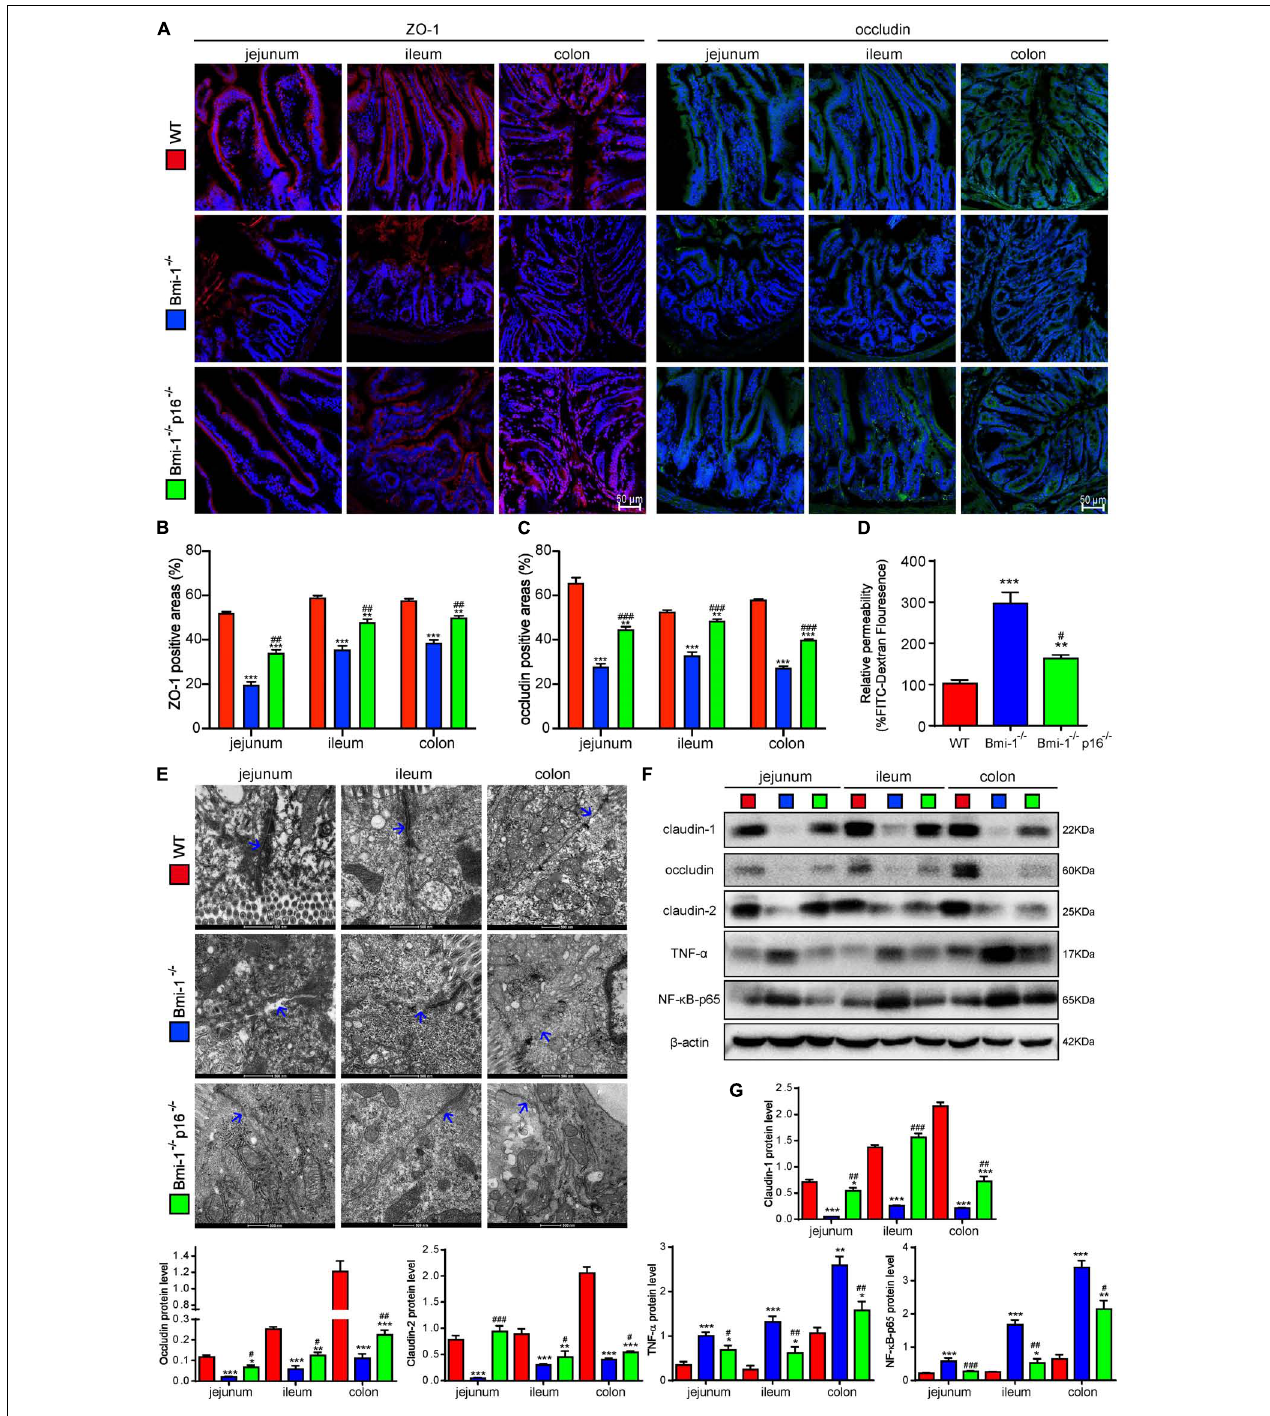
FIGURE 2 | P16 deletion improved destruction of TJ and increasing barrier permeability in intestinal epithelium in Bmi-1 − / − mice. The experiments were carried out on the 7-week-old Bmi-1 − / − , Bmi-1 − / − p16 − / − , and WT mice. (A) Representative micrographs showing immunofluorescence for ZO-1 and occludin, with DAPI staining the nuclei. (B) Percentage of ZO-1–positive areas relative to the total area. (C) Percentage of occludin-positive areas relative to the total area. (D) Intestinal FITC–dextran transmittance showing intestinal permeability. (E) Representative micrographs showing transmission electron microscope for the epithelial cells of jejunum, ileum, and colon, with blue arrow showing the bottom of the epithelial TJ. (F) Western blots for claudin-1, occludin, claudin-2, TNF- α , and NF- κ B–p65 in the epithelial cells of jejunum, ileum, and colon; β -actin was used as the loading control. (G) Protein levels relative to β -actin were assessed by densitometric analysis. Six mice per group were used for experiments. Statistical analysis was performed with one-way ANOVA test. Values are mean ± SEM from six determinations per group, * p < 0.05, ** p < 0.01, *** p < 0.001 compared with the WT group; # p < 0.05, ## p < 0.01, ### p < 0.001compared with the Bmi-1 − / − group.